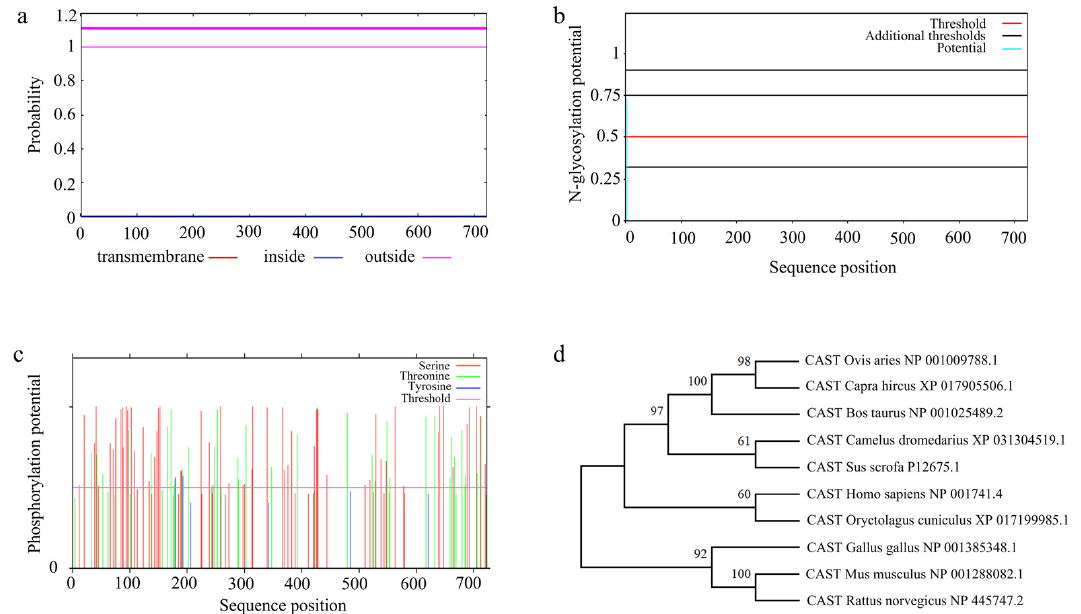
Figure 7. Amino acid sequence analysis of ovine CAST and its multiple sequence alignments. ( a ) CAST protein transmembrane helices were predicted. ( b ) CAST protein N-glycosylation sites were predicted. ( c ) CAST protein phosphorylation sites were predicted. ( d ) A phylogenetic tree was con- structed based on CAST homology amino acid sequences.